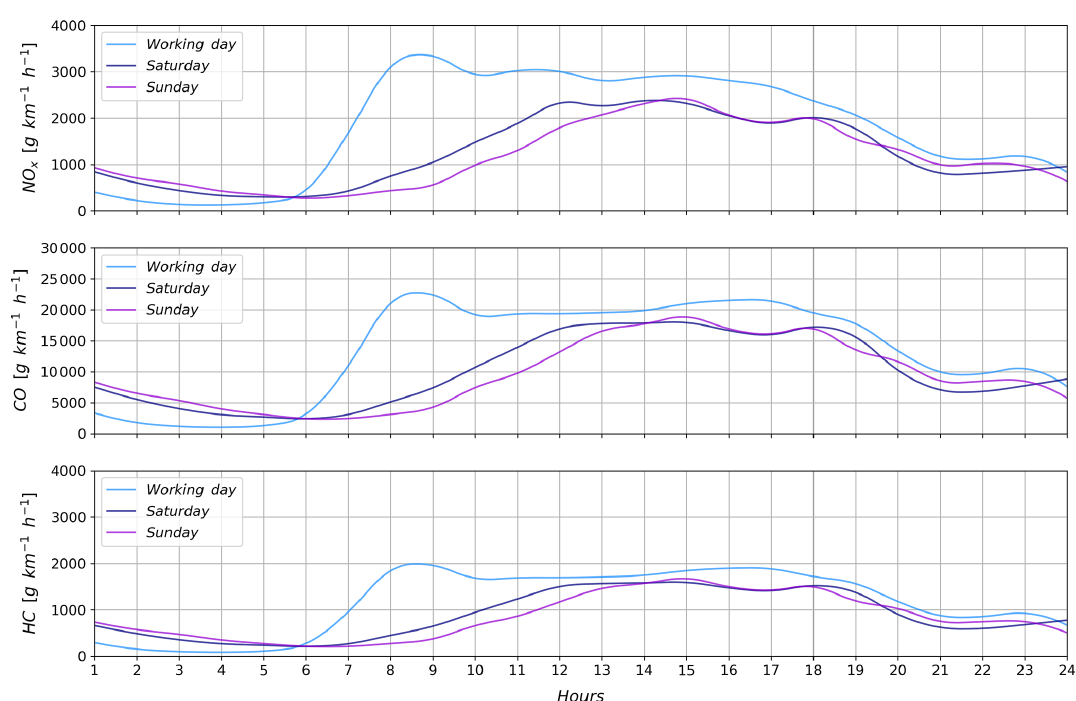
Figure A1. Time series of diurnal cycle emissions on a typical Saturday, Sunday, and working day during a week at Jagtvej Street, Copen- hagen,